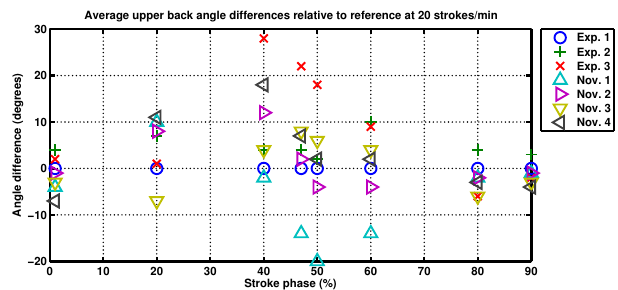
Figure 3: Average upper back angle differences at 20 strokes per minute.